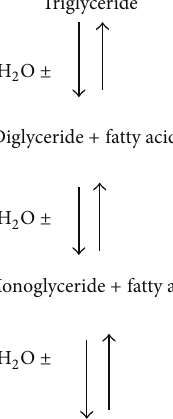
Figure 1: Diagrammatic representation of a lipase molecule show- ing its main features.